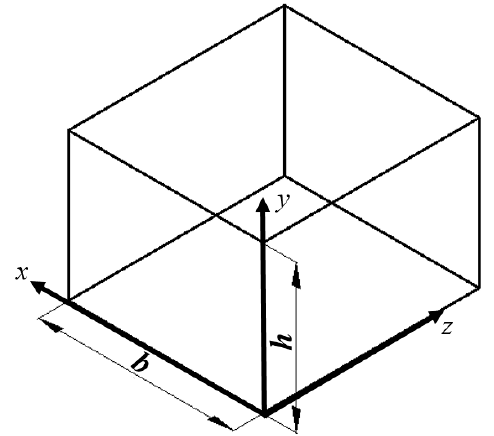
Figure 2. A straight rectangular duct.